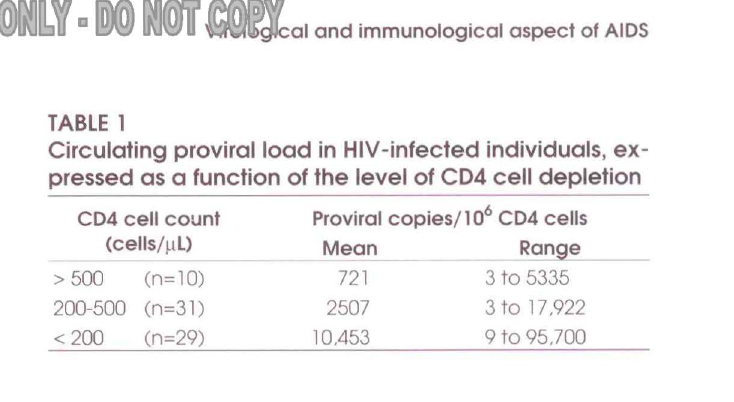
Circulating proviral load in HIV-infected individuals, ex pressed as a function of the level of CD4 cell